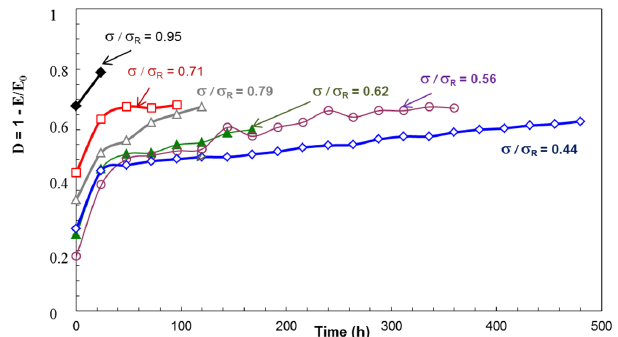
Figure 5. Evolution of the damage parameter D during static fatigue experiments for various σ / σ R ratios 0.44, 0.56, 0.62, 0.71, 0.79 and 0.95 at 500 °C on SiC f /[Si-B-C] composites.